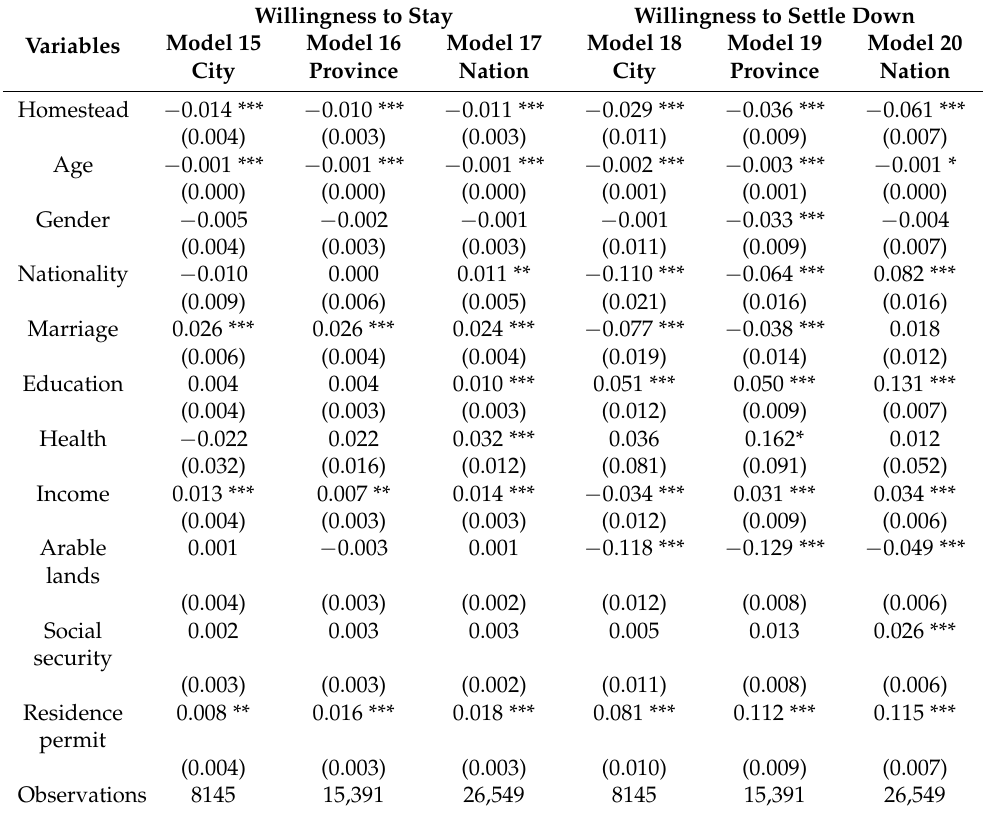
Table 6. Regression results by region (average marginal